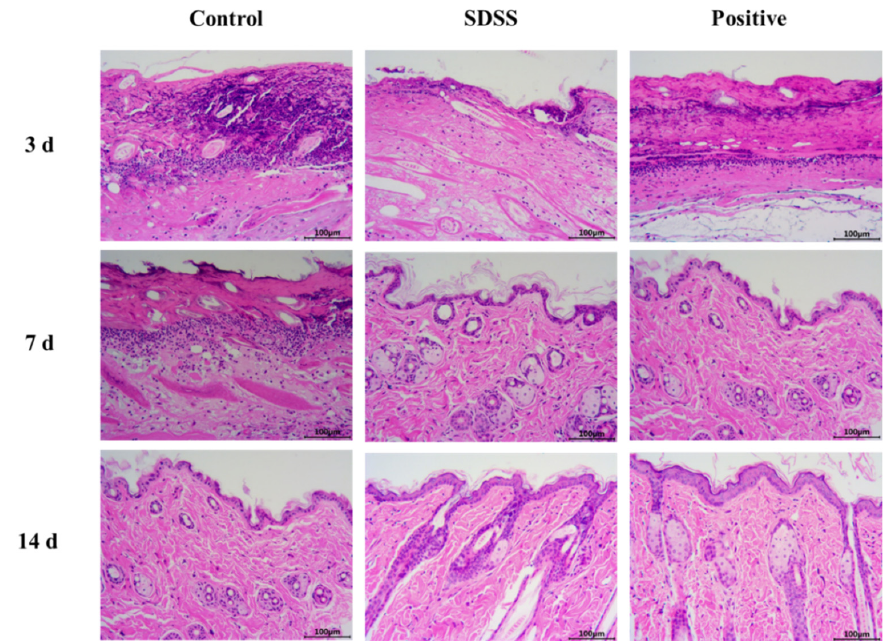
Figure 3. The H&E staining of PU on days 3, 7, and 14 after different treatments